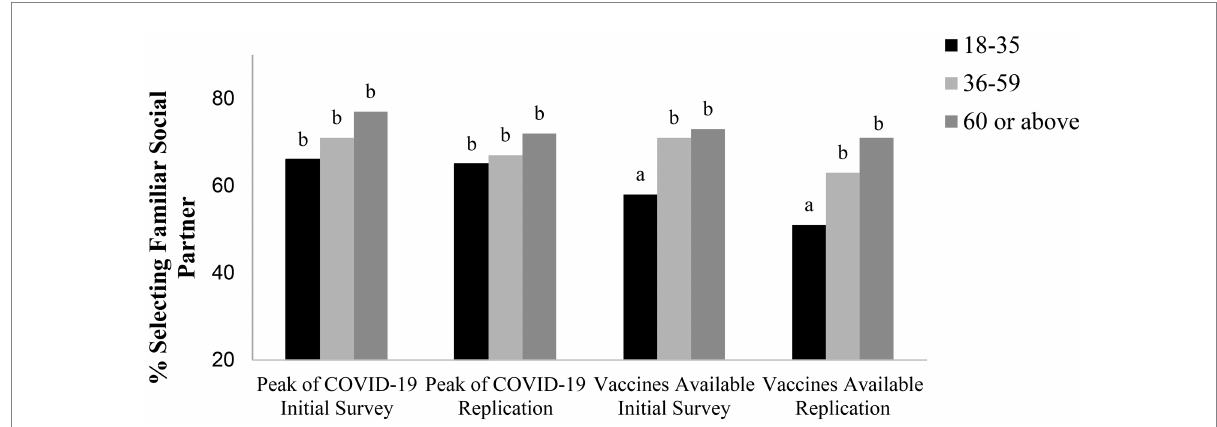
FIGURE 1 Percent selecting the emotionally close partner by age groups (18–35, 36–59, 60 or above years old) during the peak of the pandemic (two replicated studies) and after the vaccines were made available (two replicated studies). For each sample, percentages with different